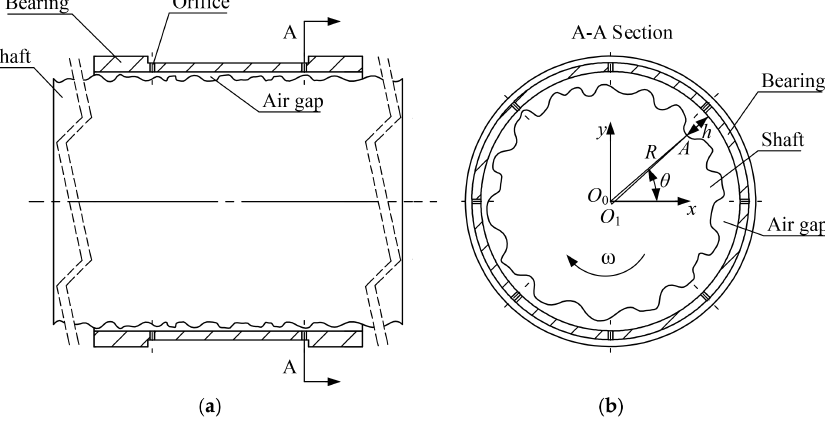
Figure 1. Illustration of the aerostatic journal bearing with shaft shape errors: ( a ) axial direction; ( b ) circumferential